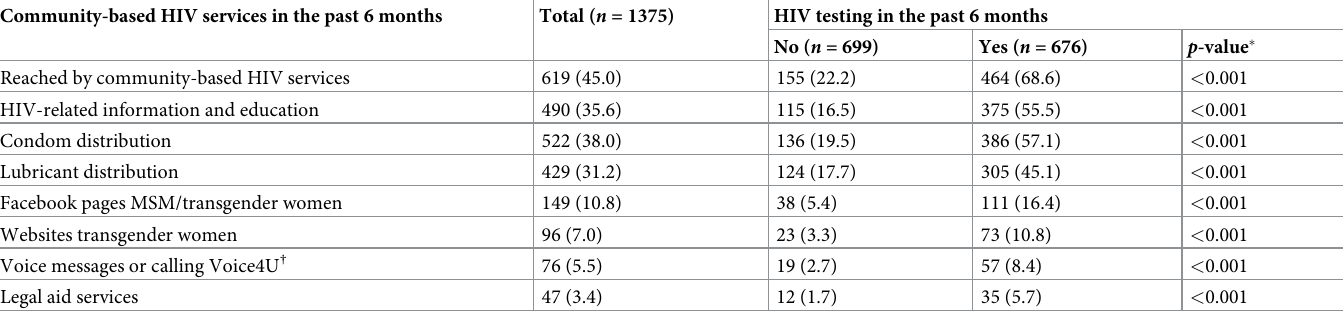
Table 3. Comparisons of access to community-based HIV services among transgender women who had and who had not tested for HIV. Community-based HIV services in the past 6 months